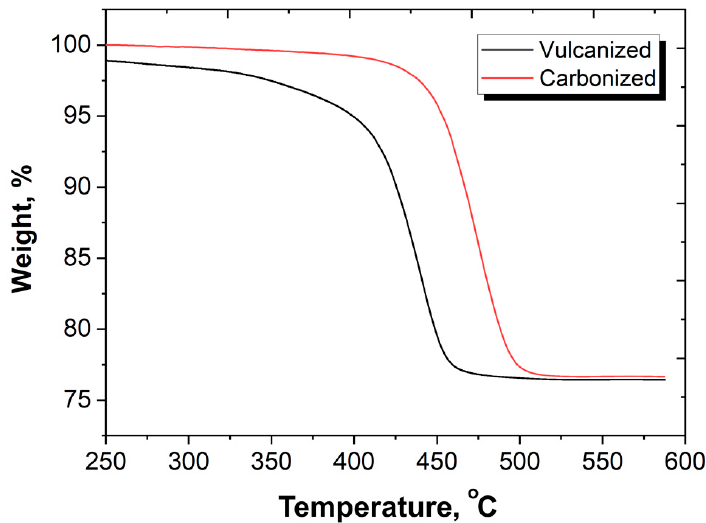
Figure 11. TGA curves of vulcanized and carbonized samples with SiC of 200 PHR.